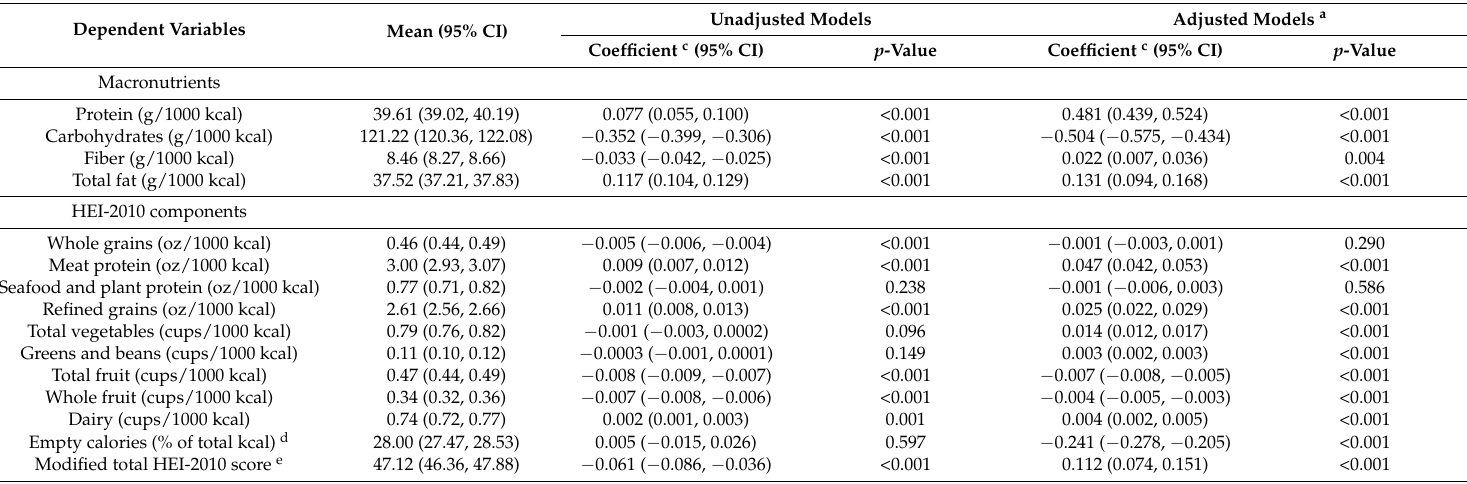
Table 3. Unadjusted and adjusted a linear regression coefficients from analyses of total sodium b (per 100 mg/day) with each macronutrients and HEI-2010 components (dependent variables)—National Health and Nutrition Examination Survey, 2011–2014 ( n =